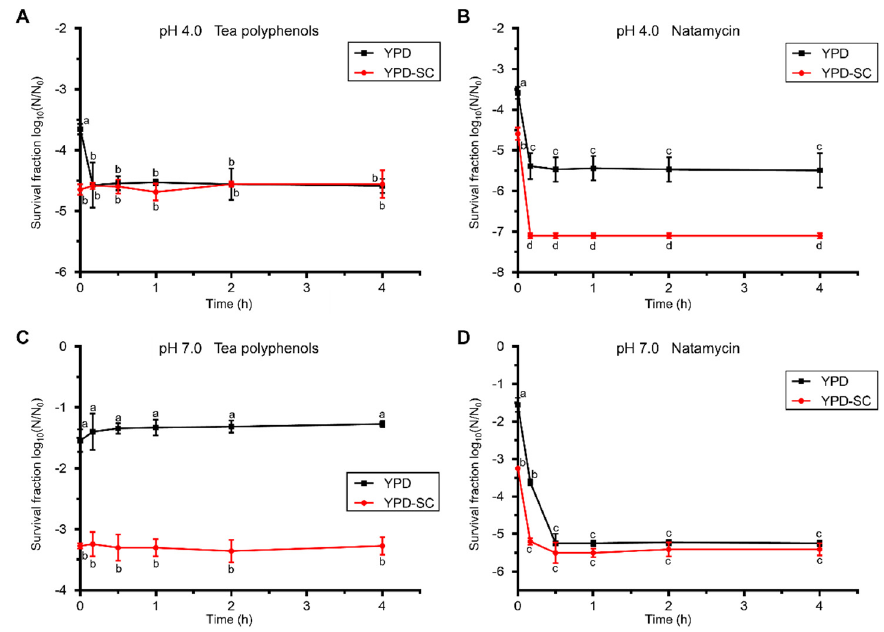
Figure 3. The effect of natural preservatives on the recovery of PEF-injured S. cerevisiae . Survival fraction of S. cerevisiae after the PEF treatment (20 kV/cm for 200 μ s) in citrate – phosphate buffer with pH 4.0 ( A , B ) and pH 7.0 ( C , D ), and in the subsequent recovery process incubated at 30 ° C for 4 h in mediums with tea polyphenols ( A , C ) and natamycin ( B , D ). YPD, non-selective medium; YPD-SC, selective medium. Data are expressed as mean ± standard deviation. Significant differences are indicated by different letters ( p < 0.05).